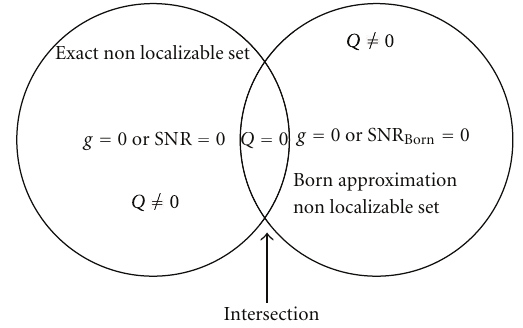
Figure 3: Venn diagram illustrating the relations between the nonlocalizable sets in configuration and parameter space for the exact and approximate models. Note that, as shown in the paper, the two sets are of the same size, and the intersection between them is defined by the condition Q =